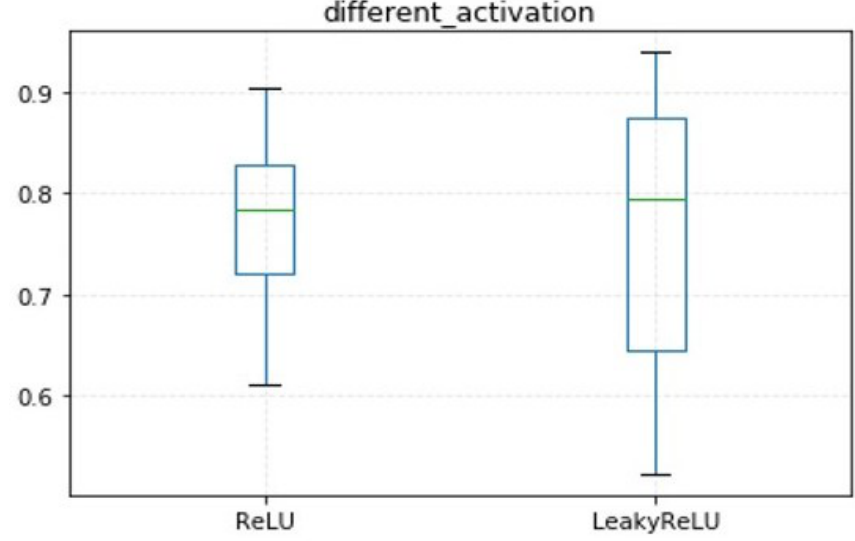
Figure 9. AUC average box and whisker after model training 10 times.